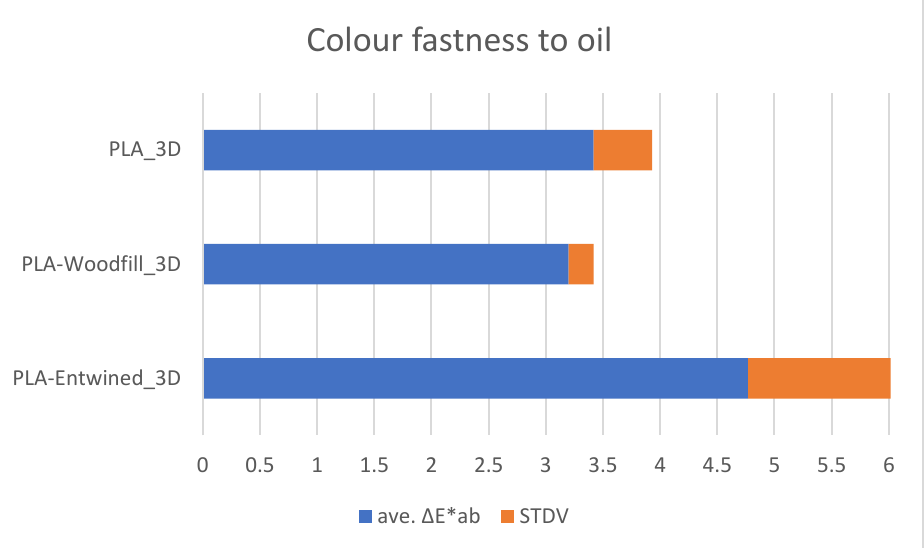
Figure 9. Colour fastness to oil.